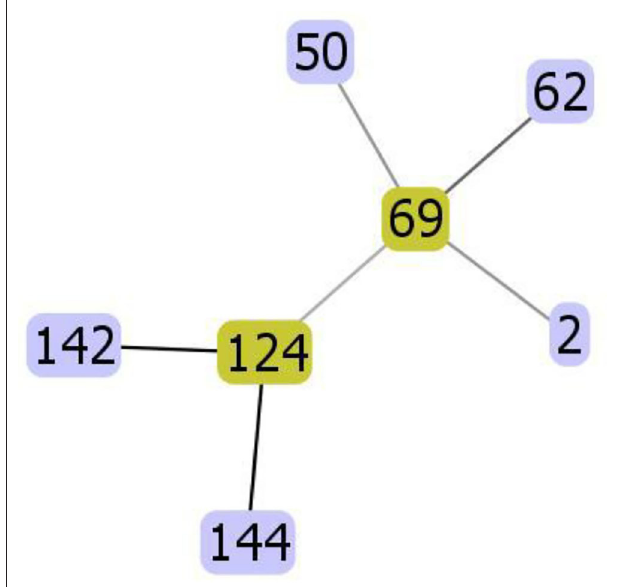
FIGURE 4 | The evolutionary relationships between the diploid sequence types (DSTs) of C. albicans . The isolates clustered in two clades; clade 1 (DST2, DST50, DST62, DST69) and clade 4 (DST124, DST142,